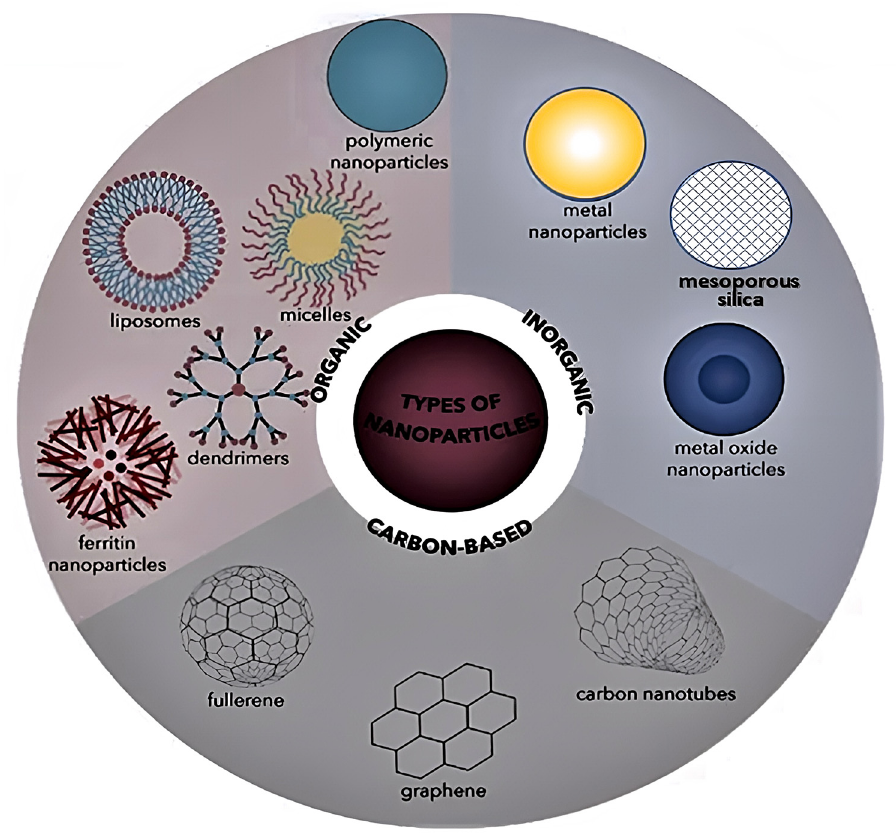
Figure 1. Classification of the main types of nanomaterials according to their nature into organic, inorganic and carbon-based.